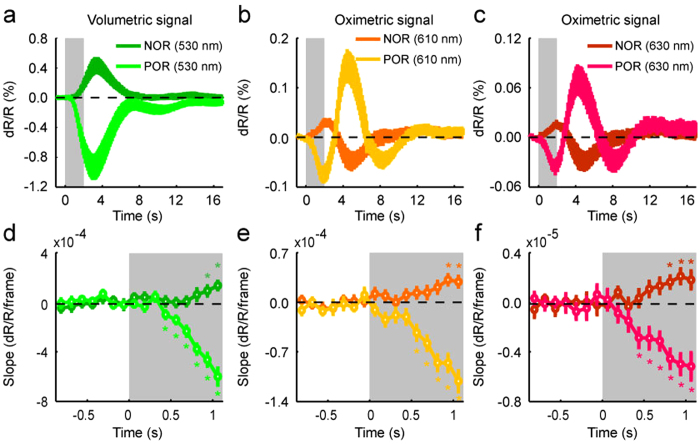
Temporal patterns of antagonistic activation by TcES (20 Hz, 1.2 mA, 10 ms).(a−c) Temporal profiles of volumetric and oximetric signal changes after TcES averaged across 16 cats. (d−f) The slopes of reflectance changes for volumetric and oximetric responses. *indicates slopes significantly different from response baseline (Wilcoxon test, P < 0.05, n = 16). The gray rectangles denote the stimulus duration, which also shown in Figs 3, 4, 5. Error bars show SEM.